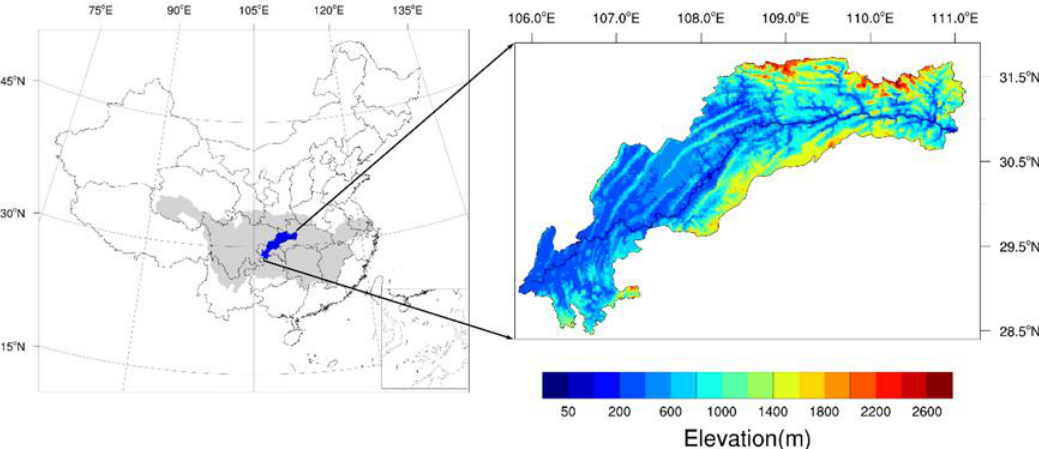
Figure 1. Study area and location of the Three Gorges Reservoir (TGR) region in the Yangtze River Basin.